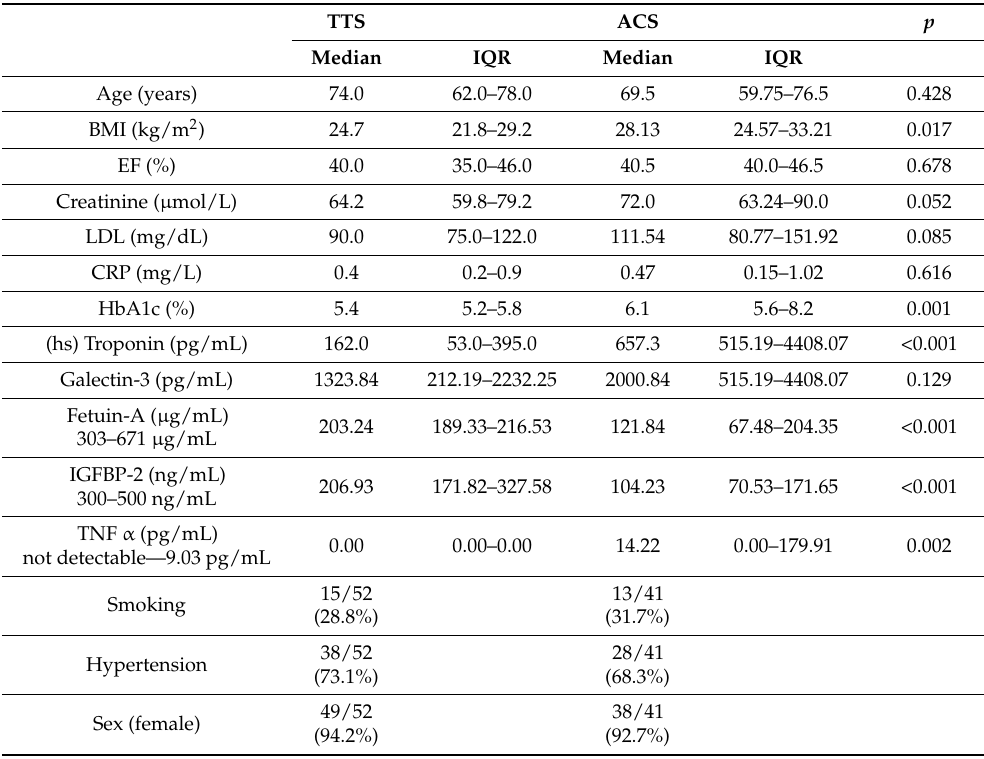
Table 1. Baseline characteristics of patients suffering from TTC or ACS, given as median and IQR. p = significance between TTC and ACS